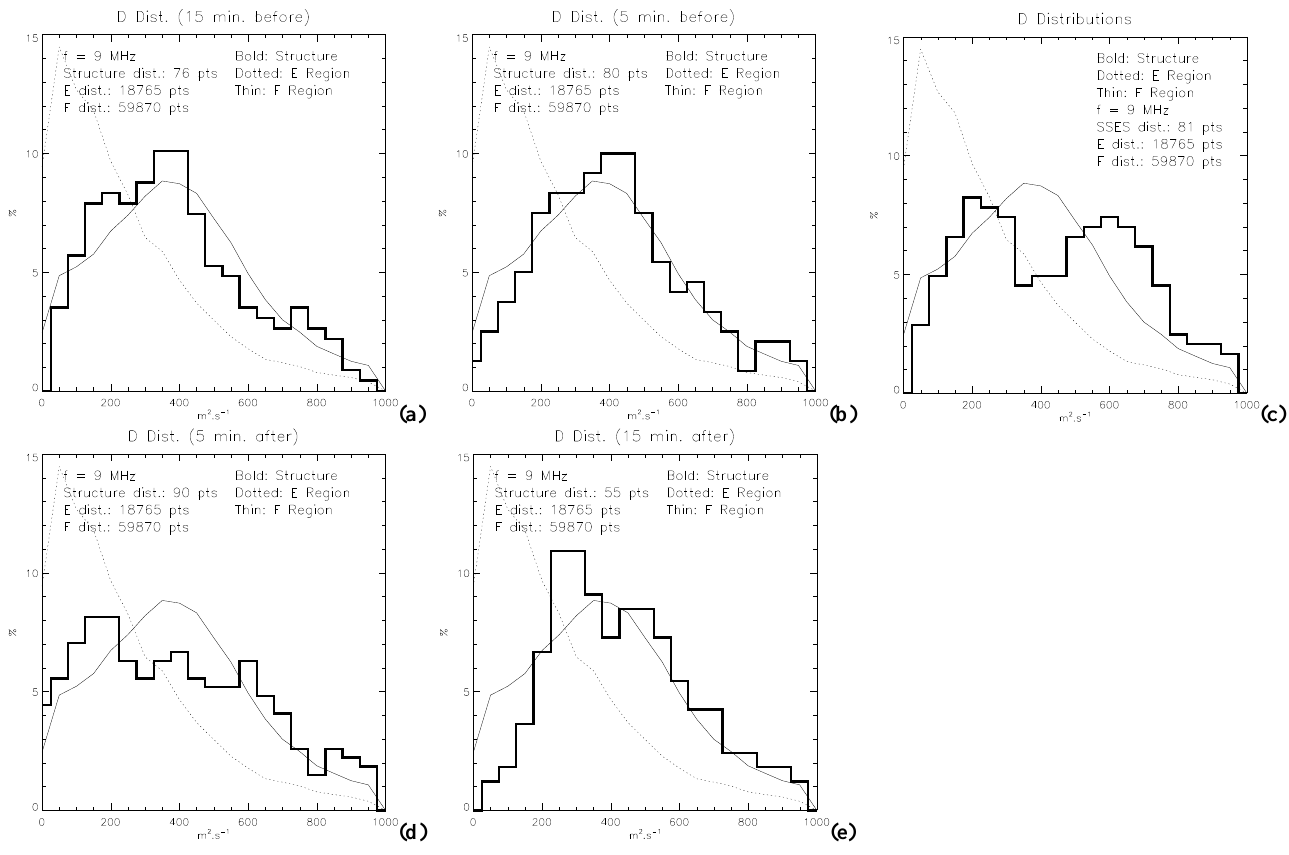
Fig. 3. Variation of the diffusion coefficient D at several times before (a, b) , during (c) and after (d, e) the peak of the